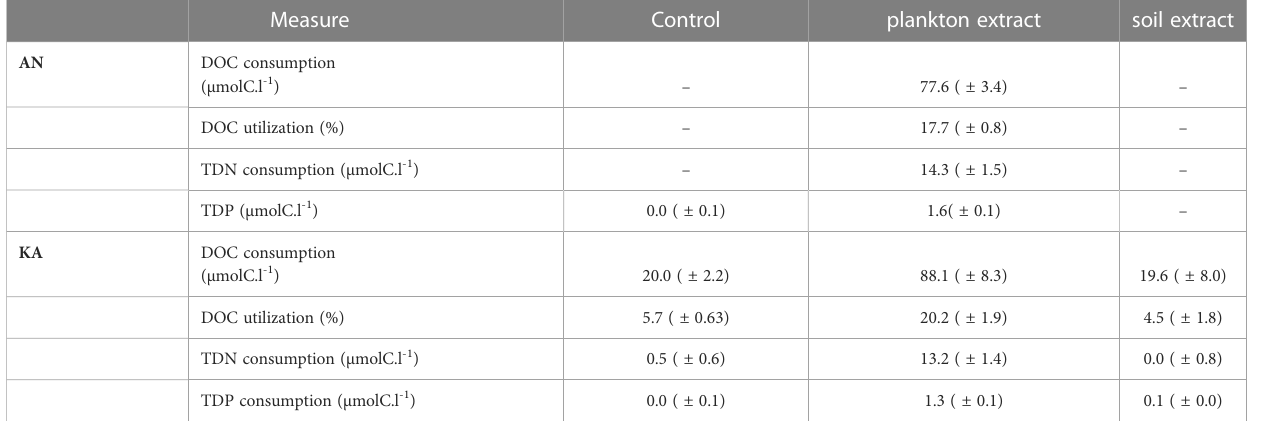
TABLE 2 Comparison of the bacterial DOC, TDN and TDP consumption and percentage DOC utilization in different